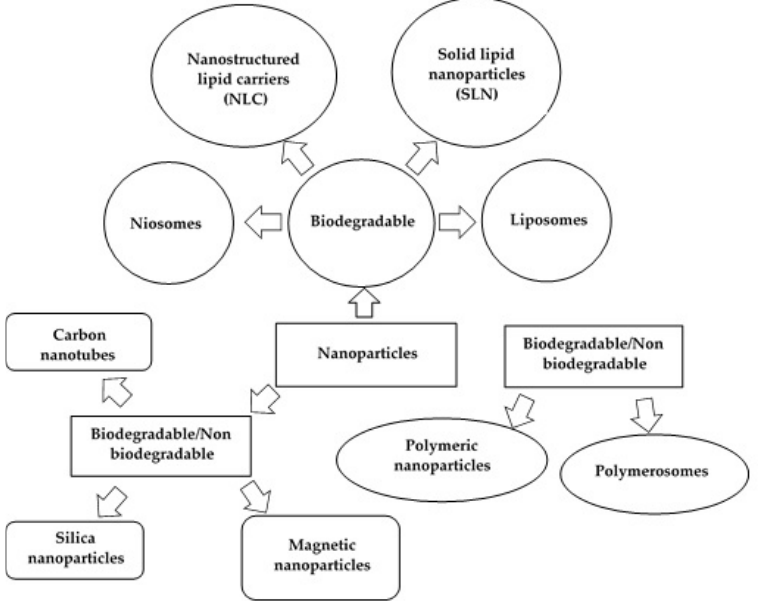
Figure 1. Schematic diagram showing different types of nanoparticles (modified from [1]; original paper under the terms of the Creative Commons CC BY-NC